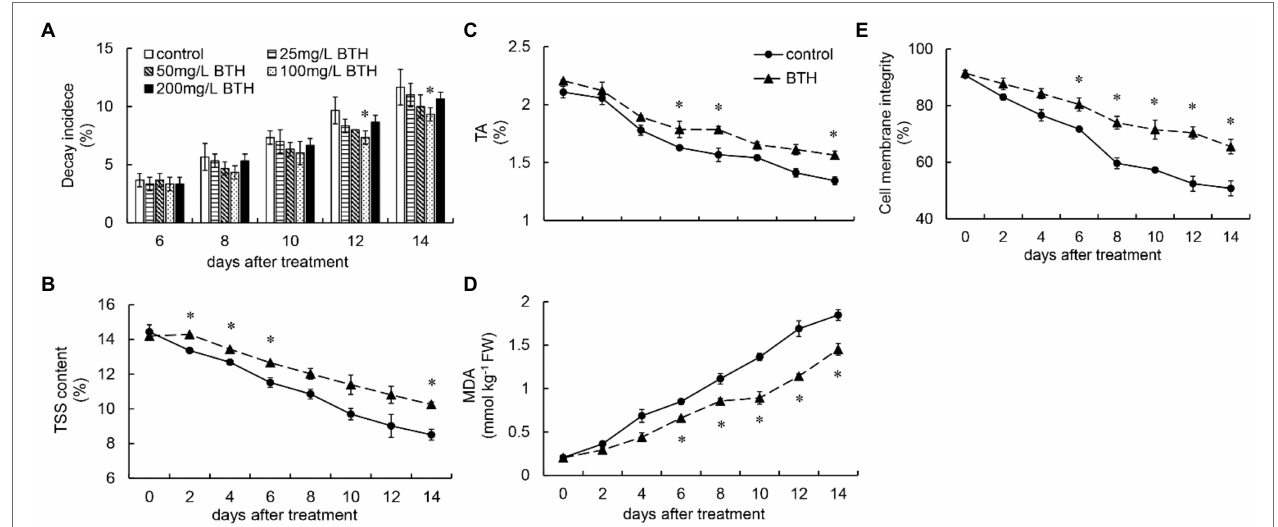
FIGURE 1 | Effect of benzothiazole (BTH) treatment on the decay incidence (A) , titratable acidity (TA; B ), total soluble solid (TSS; C ), malondialdehyde (MDA) content (D) , and cell membrane integrity (E) of R. roxburghii fruit. The significant differences at a level of 0.05 by Fisher’s least significant difference (LSD) between the control and BTH-treated fruit are indicated by asterisks (*). Vertical bars represent the standard errors of the means